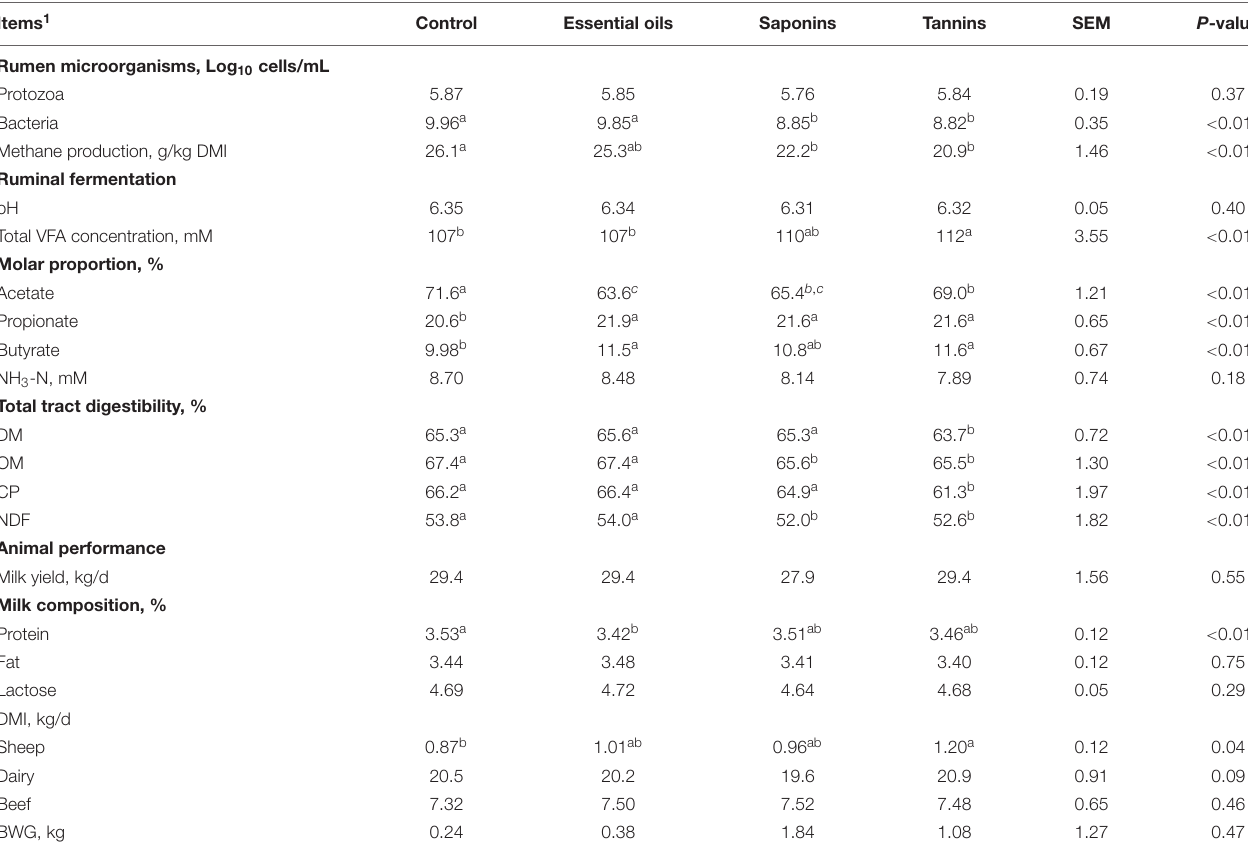
Items 1 Control Essential oils Saponins Tannins SEM P